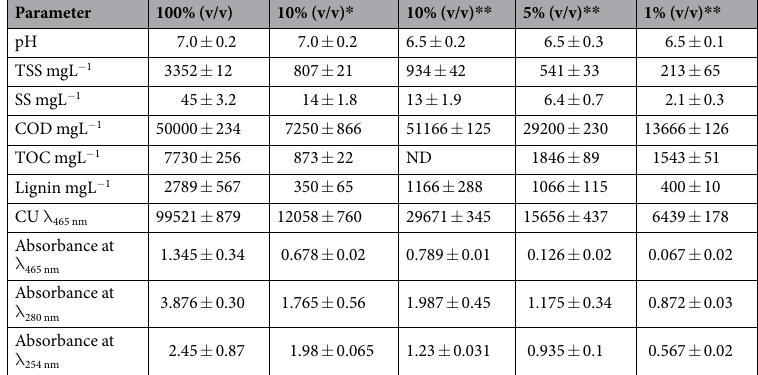
Table 1. Characterization of synthetic black liquor (SBL). Elevated concentrations of CU, COD, TOC and lignin were obtained, mainly from lignin solubilisation in 100% SBL, as a product of the alkaline extraction process. Additionally, aliphatic compounds of different molecular weights were detected. These compounds could affect the COD, TSS, and SS. Elevated absorbency values at different wavelengths could be associated with the presence of aromatic compounds, lignins, and chromophore groups. Asterisks in the table indicate the following: * Concentration of SBL supplemented for P. ostreatus . ** Concentration of SBL supplemented for P. pastoris . TSS (total suspended solids), SS (sedimented solids), COD (chemical oxygen demand), TOC (total organic carbon), CU (colour units). All data are expressed as averages ±